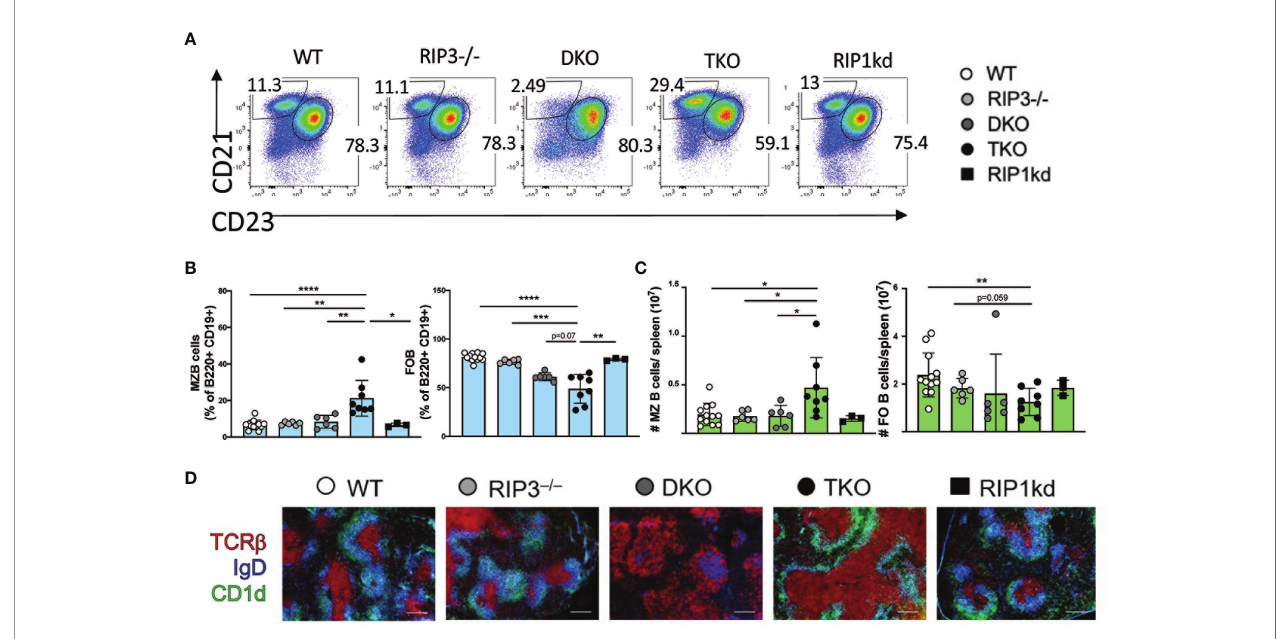
FIGURE 2 | RIP1 and caspase-8 are required for innate MZ B cell homeostasis. Flow cytometry of C57BL/6 WT, RIP3-/-, DKO, TKO and RIP1 kd splenocytes identi fi es percent of B220 + , CD19 + B cells which are CD21 hi CD23 lo MZ B cells and CD21 lo CD23 hi FO B cells as indicated on plots (A) and quanti fi ed in (B) . Number of MZ B cells and FO B cells per spleen are quanti fi ed in (C) . Immuno fl uorescent labeling of 8 m m thick spleen sections from C57BL/6 WT, RIP3-/-, DKO, TKO and RIP1 kd mice identi fi es the T cell zone (anti-TCRb), B cell follicle (anti-IgD), and the marginal zone (anti-CD1d) (D) . Data is representative (A, D) or a pool (B, C) of three independent experiments with 2-4 mice per group, 8-14 weeks old. Each symbol indicates an individual mouse. *p ≤ 0.05, **p ≤ 0.01, ***p ≤ 0.001, ****p ≤ 0.0001 (One-way ANOVA). Scale bar=200 m